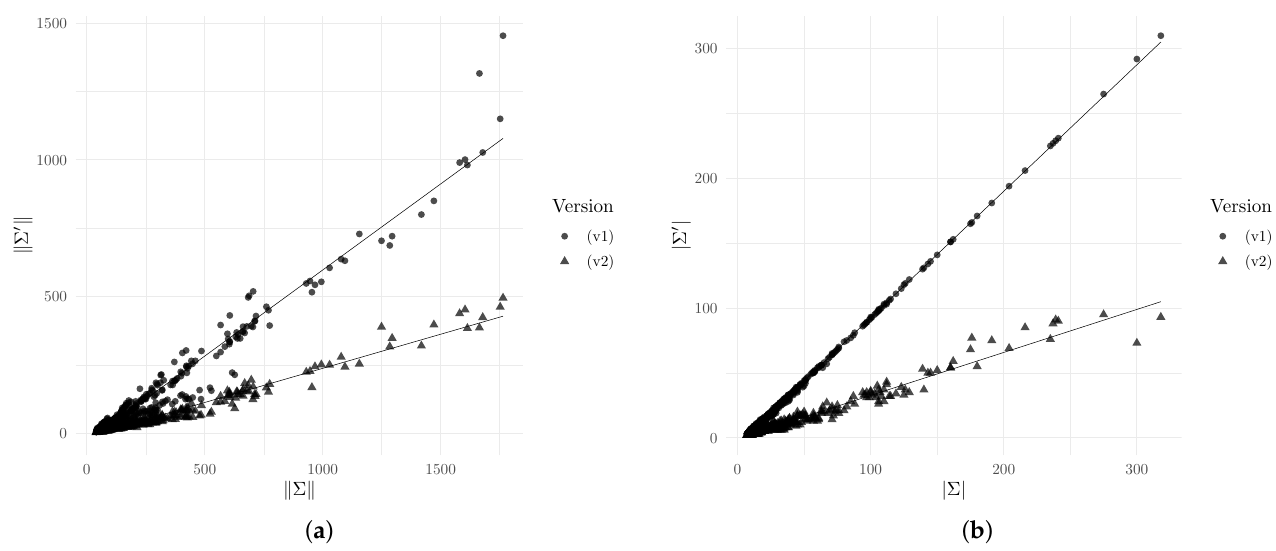
Figure 1. Comparison of versions (v1) and (v2) with respect to a reduction ratio of ( b ) for all the datasets used in the experiments.